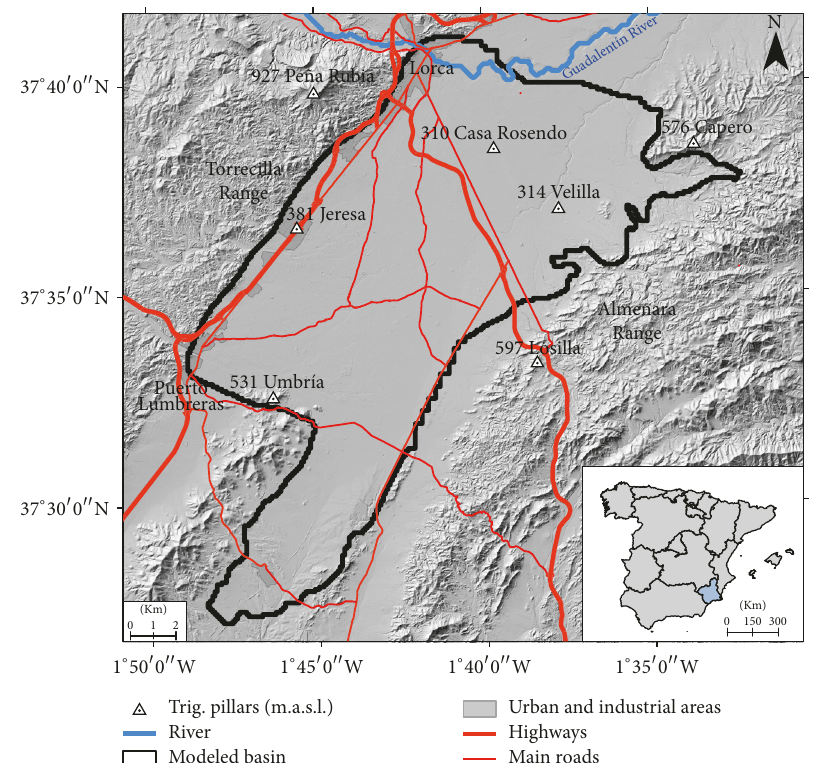
Figure 1: Location map. The MDT05-Lidar digital elevation model was used to generate the background topography. Names for the main cities, water courses, and ranges in the study area are